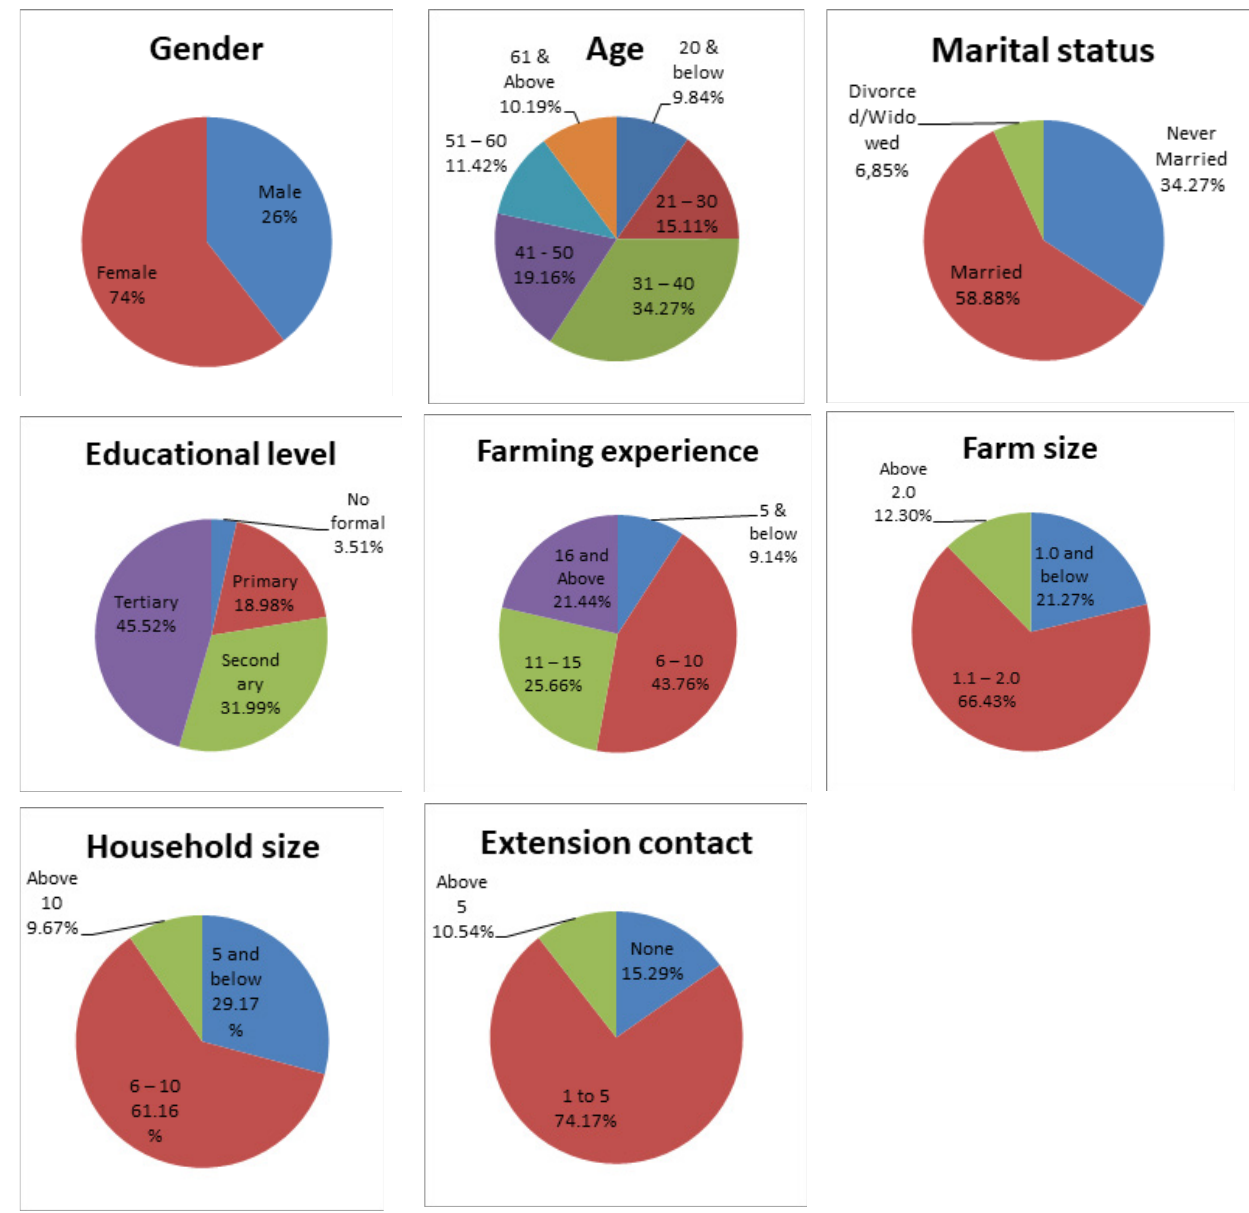
Figure 1: Pie charts presentation of socio-economic variables of respondents Table 3: Prevalent diseases of cassava